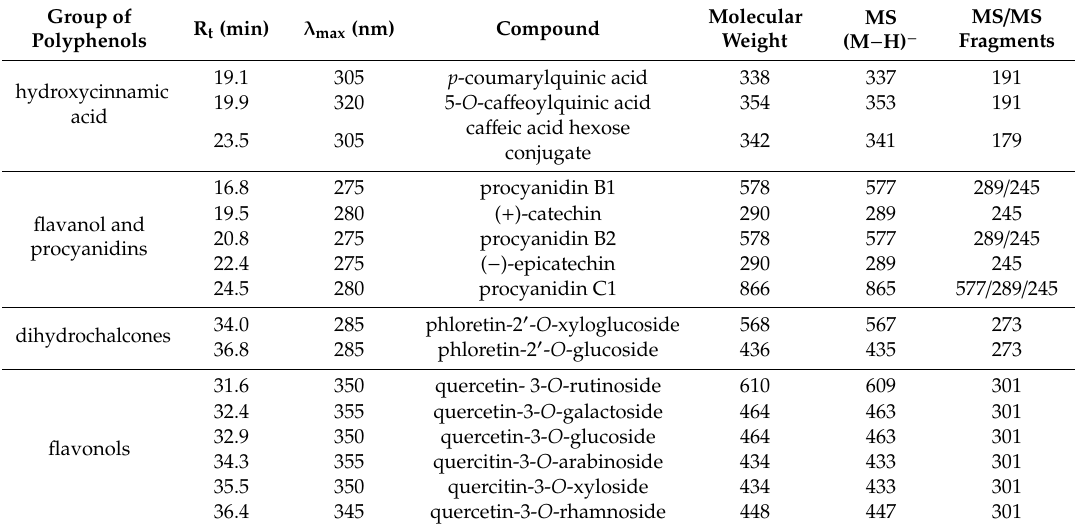
Table1. Characterizationofthephenoliccompoundsofapplefruitsbyusingtheirspectralcharacteristics in LC–diode array detector (DAD) (Retention Time λ max ) negative ions in